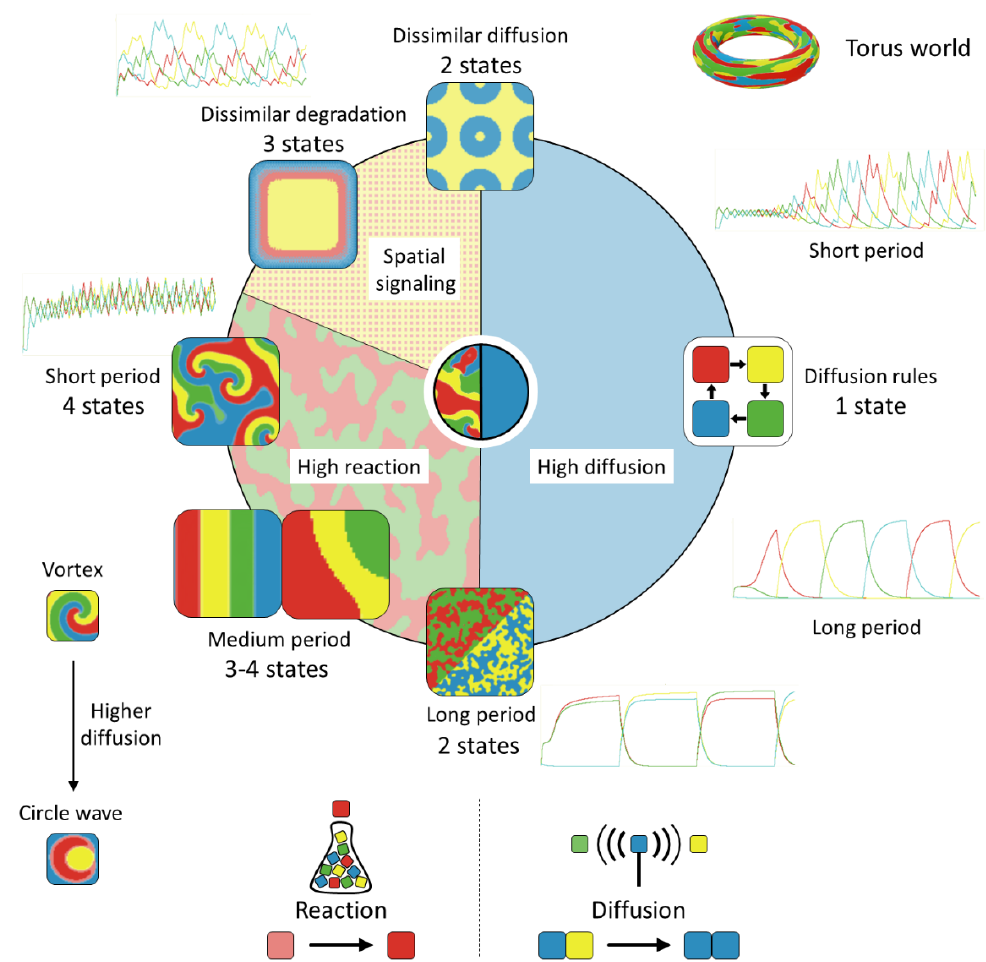
Figure 10. Scheme of the main attractors that can be gathered after 100,000 time steps by tuning the process characteristics of the torus CA through its parameters. When reaction rules, signaling can be tested as a spatially homogeneous property or as grid. The time evolution of each protein concentration during the first 3000 steps is also included for some assessed cases, including those when diffusion rules for long and also short signal periods. The number of dominant states is also indicated for each case.